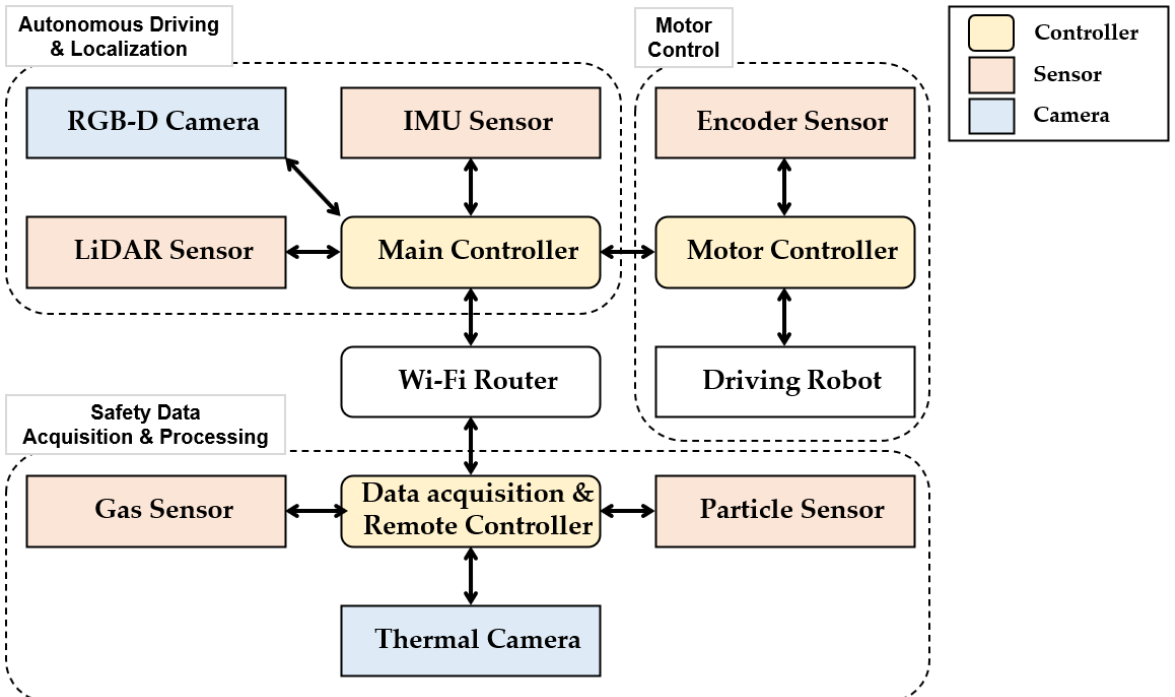
Figure 1. Overall structure of the autonomous driving robot developed in this study.